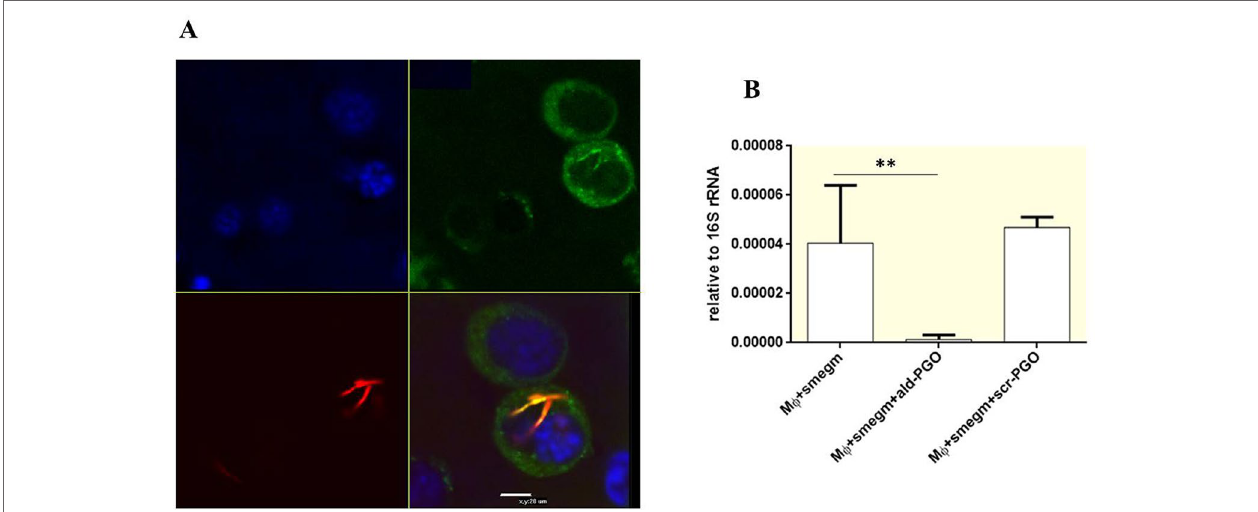
FIGURE 5 | Intracellular effect of 2 ′ -OMe PGO on mycobacteria. (A) Confocal microscopy of RAW 264.7 macrophages infected with Mycobacterium smegmatis expressing mCherry Red fluorescent protein. The infected cells were treated with fluorescently labeled ald -PGO (FAM-PGO, 10 μM) for 24 h and analyzed by confocal microscopy. M. smegmatis is red, FAM-PGO is green, and nuclei stained with Hoecst33342 are blue. (B) Quantification of ald transcription in intracellular M. smegmatis . RAW 264.7 cells were infected with mycobacteria, treated with 20 μM of the indicated ASOs, and analyzed for ald mRNA expression by qRT-PCR. The data are normalized to the 16S rRNA transcription level. ** p < 0.01. 2 ′ -OMe PGO, phosphoryl guanidine oligo-2 ′ - O -methylribonucleotide; ASOs, antisense oligonucleotides; qRT-PCR, quantitative reverse transcriptase–polymerase chain